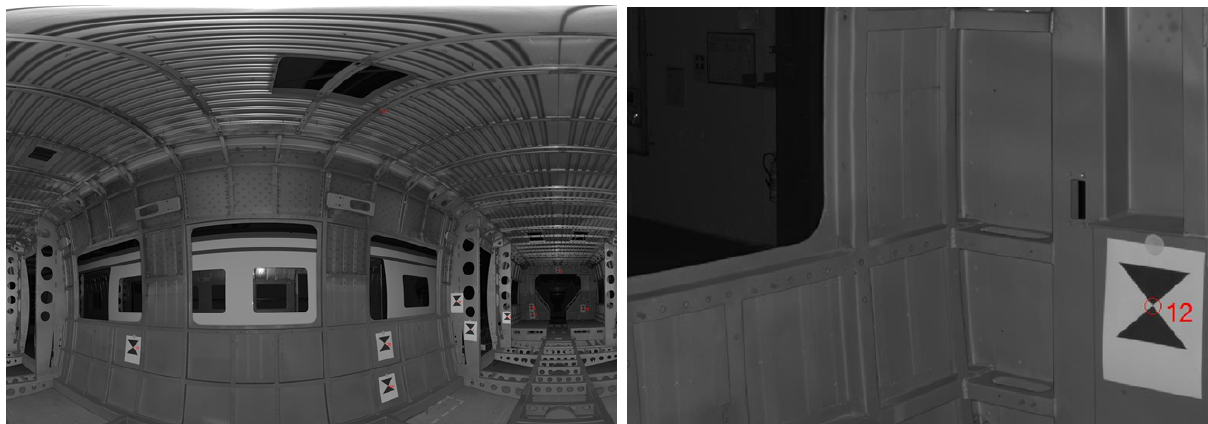
Figure 2. Example of a point cloud. The intensity of reflection (remission) is shown as a grey value, which results in a photo-realistic view of the point cloud (Jurdeczka, 2017). A detailed section is on the